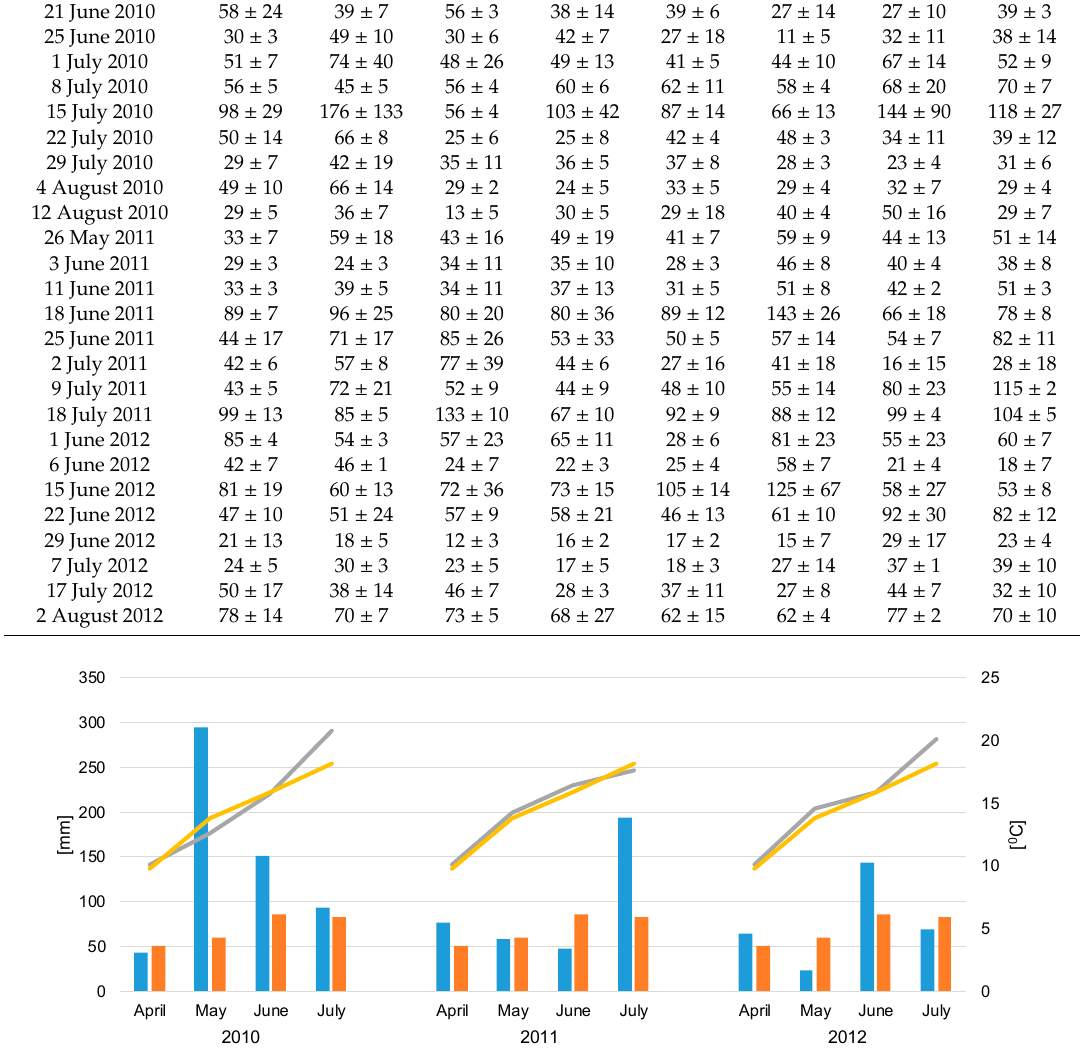
Table 2. Trapping dynamics of investigated arthropodofauna (means of individuals/trap) in broad bean crop: Treatments are the same as in Table 1. Values after ± symbol denote standard errors.